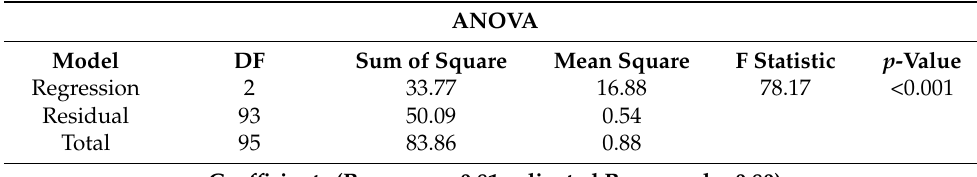
Figure 1. Scatter plot showing the maximum force–velocity exertion of the swimmers, grouped by stroke, and differentiated by swimming race distance. As shown by the best line fit, the high correlation between the force and velocity values in the single pull-up test reflects an almost linear trend. This is particularly evident within the 50 m and 100 m groups of swimmers. Table 2. Multiple linear regression analysis to predict swimming performances based on z-scored velocity and force generated in the single pull-up test. The analysis considers both the distance and stroke